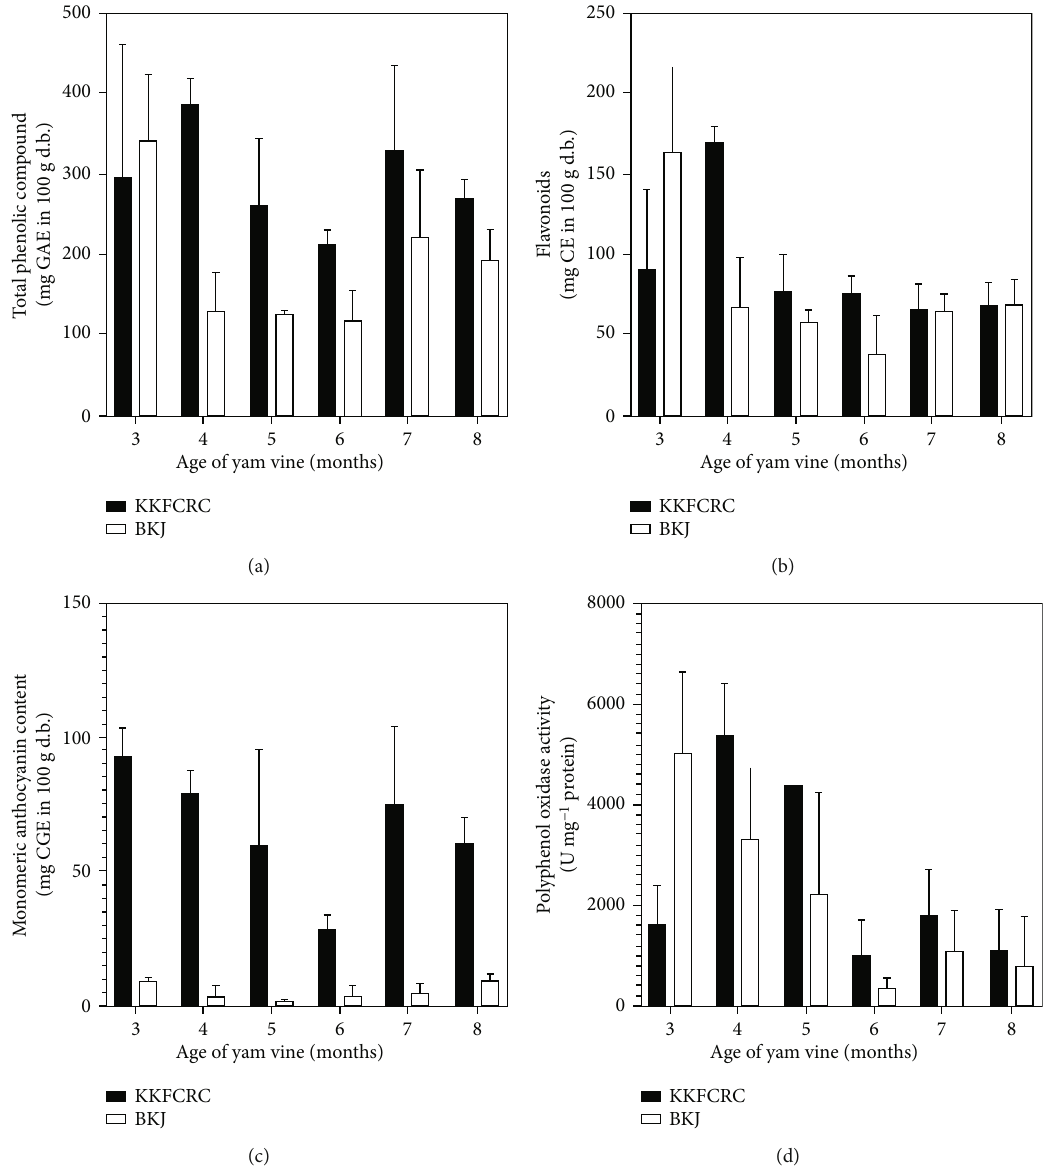
Figure 3: E ff ect of vine age and accession (KKFCRC vs BKJ) on chemical characteristics of the edible portions: (a) total phenolic compound, (b) fl avonoid, (c) monomeric anthocyanin, and (d) polyphenol oxidase activity. Bars represent standard